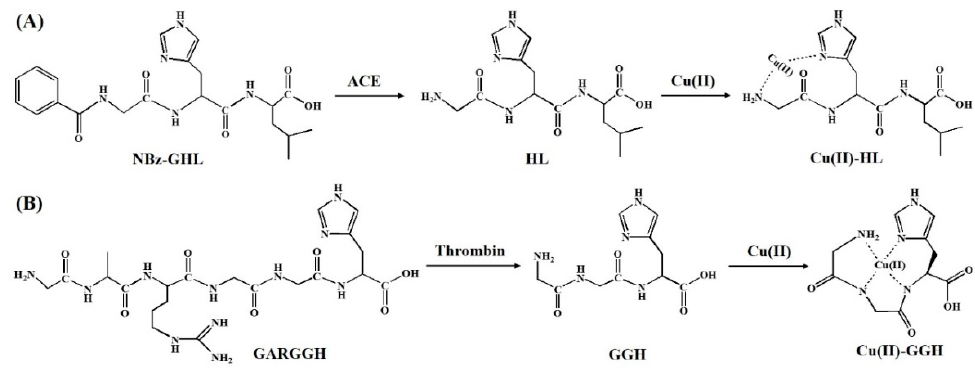
Figure 1. Schematic representation for proteolytic reactions and Cu(II) complexes.